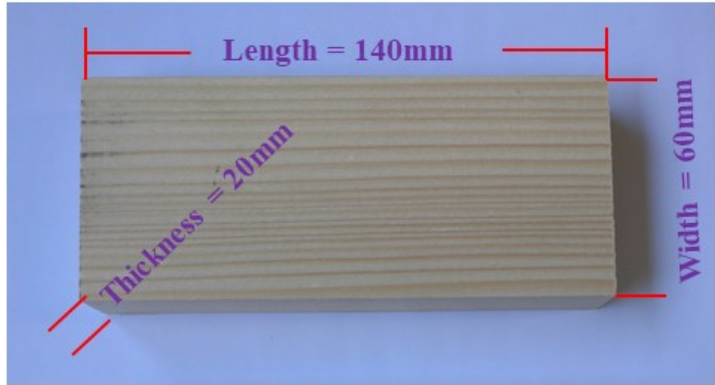
Figure 1. Schematic diagram of wood dimensions for heat treatment.